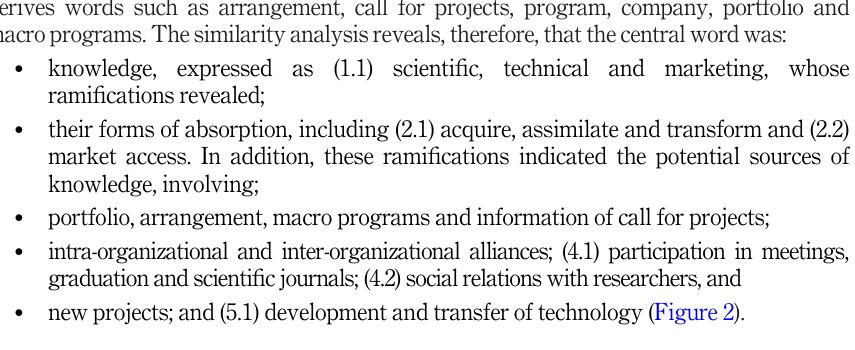
Figure 2. Similitude analysis obtained by the IRAMUTEQ